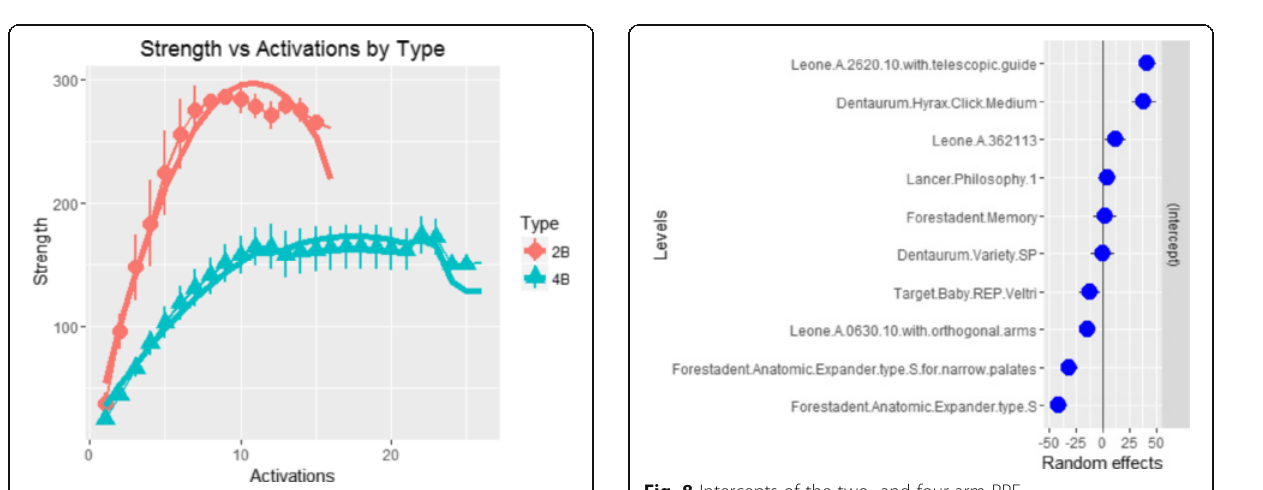
Fig. 7 Strength dynamics of the two- and four-arm RPE